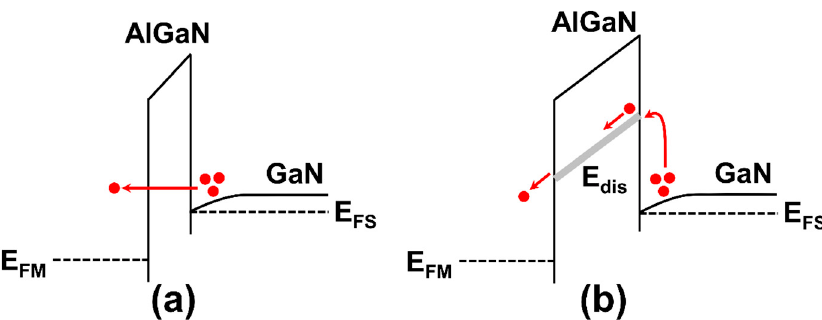
Figure 10. Schematic band diagrams presenting the dominant current transport under forward bias conditions for ( a ) 5 and ( b ) 10 nm thick AlGaN.